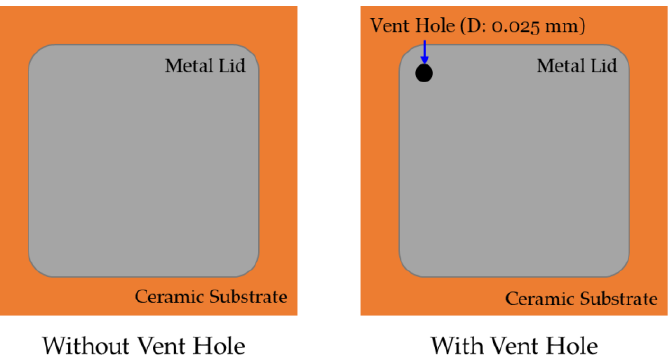
Figure 5. The schematic diagram of the hermetic MEMS package with a vent hole and without a vent hole.